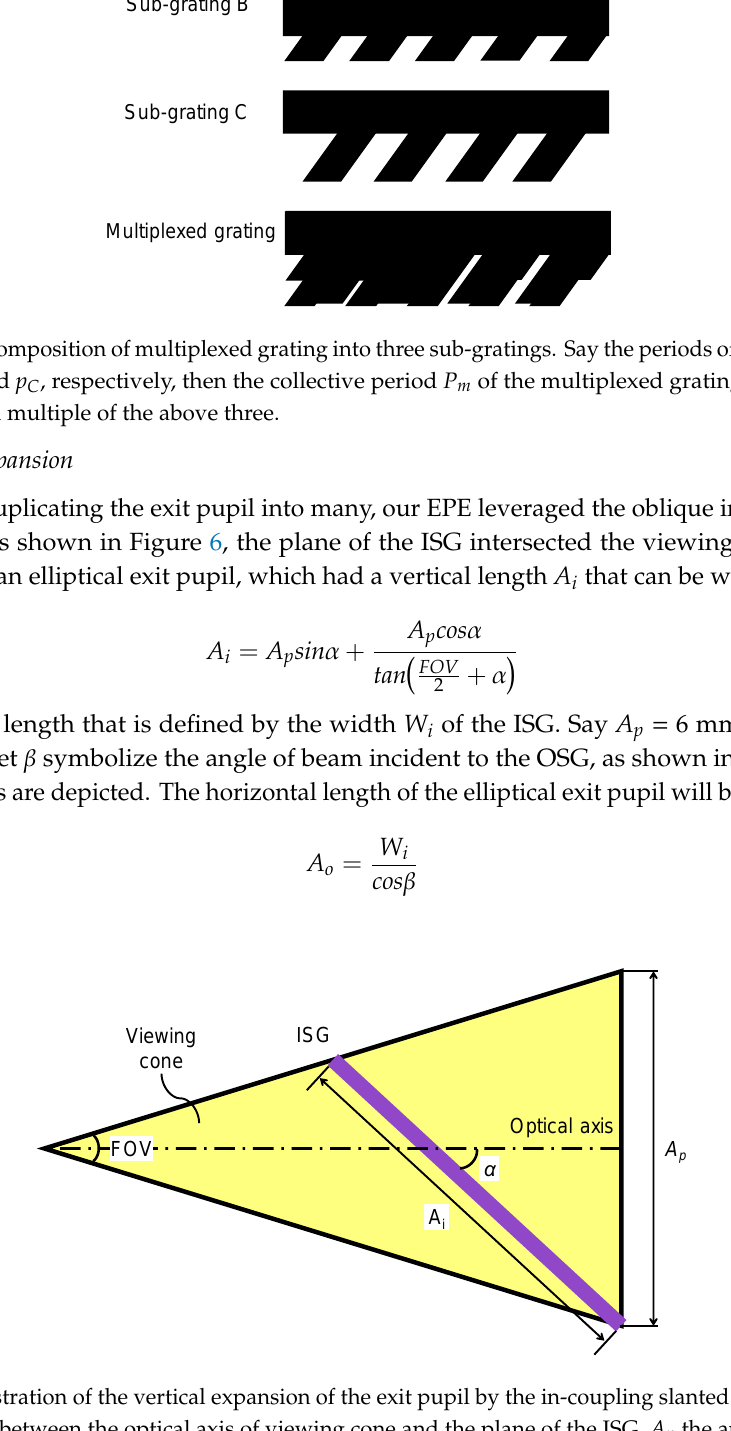
p the aperture of the